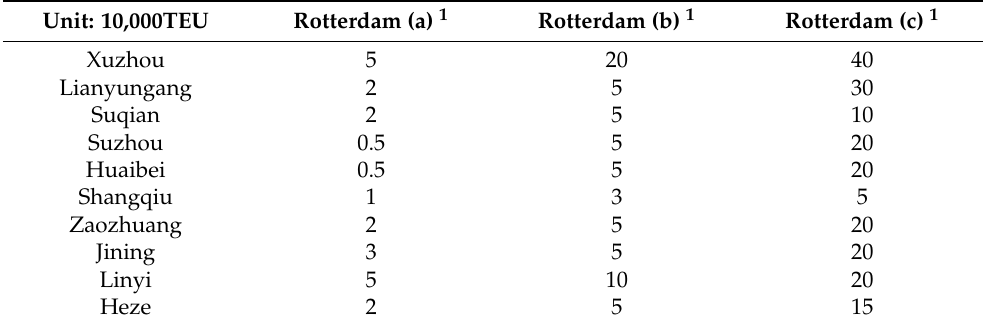
Table A5. Cross-border transportation uncertain demand between origin cities and Rotterdam.